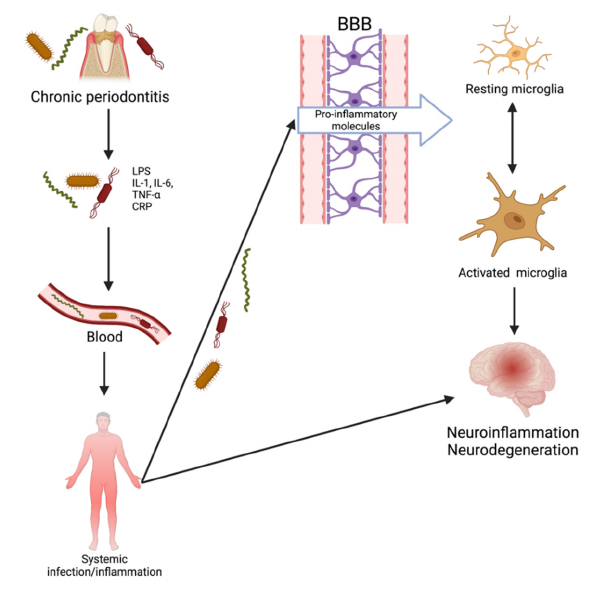
Figure 5. Transition of periodontitis to neurological disease.